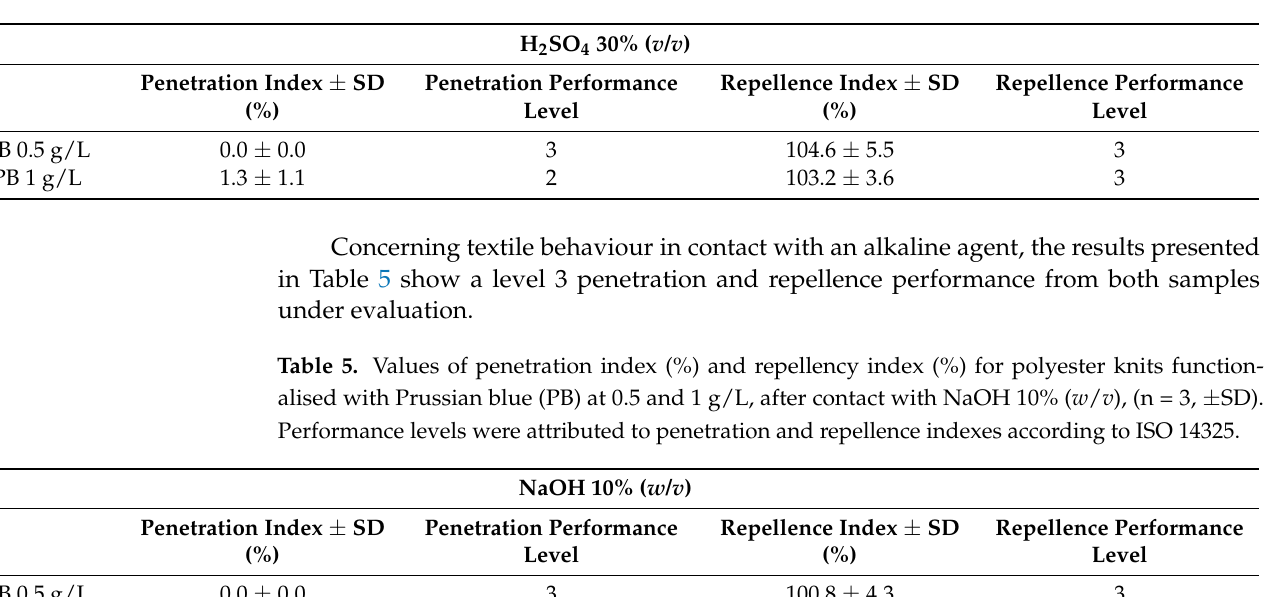
Table 4. Values of penetration index (%) and repellency index (%) for polyester knits function- alised with Prussian blue (PB) at 0.5 and 1 g/L, after contact with H 2 SO 4 30% ( v / v ), (n = 3, ± SD). Performance levels were attributed to penetration and repellence indexes according to ISO 14325.